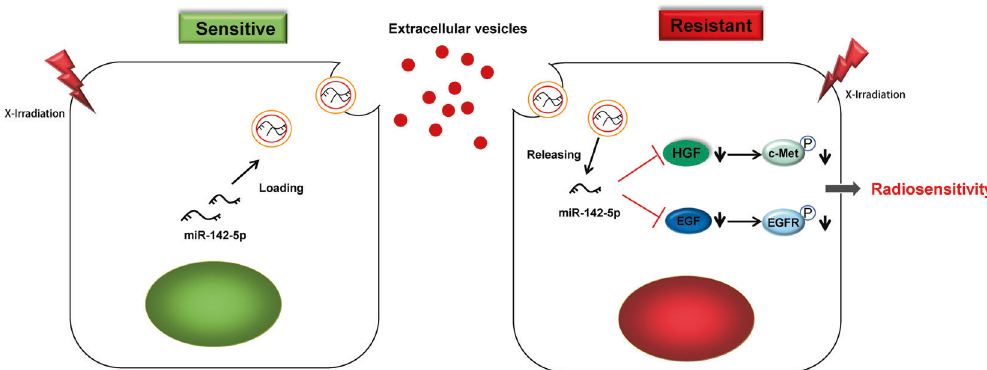
Fig. 8 Mechanism of miR-142-5p delivered by TEVs in radiosensitivity of NPC by regulating HGF/c-Met and EGF/EGFR